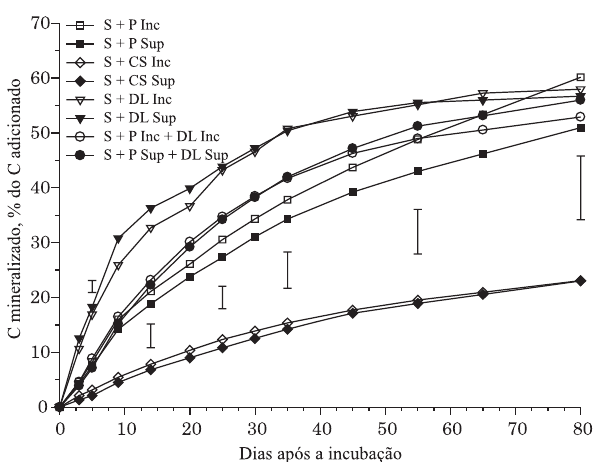
Figura 3. Carbono mineralizado da palha de aveia (P), dos dejetos de suínos (DL) e da cama sobreposta (CS) utilizados isoladamente ou em conjunto, na superfície (Sup) ou incorporados (Inc) ao solo. As barras verticais representam a diferença mínima significativa entre as médias de cada tratamento (Tukey a 5